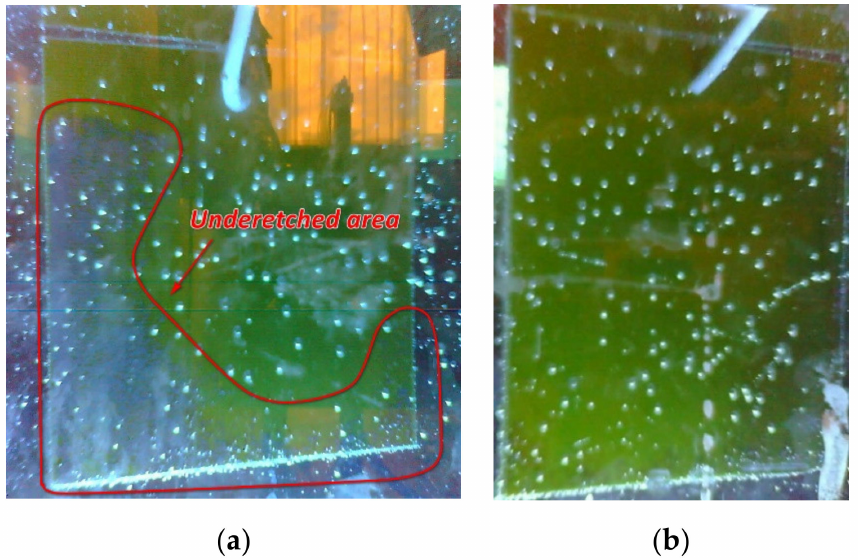
Figure 22. Result of etching of the last workpiece, ( a ) top side of the workpiece, ( b ) bottom side of the